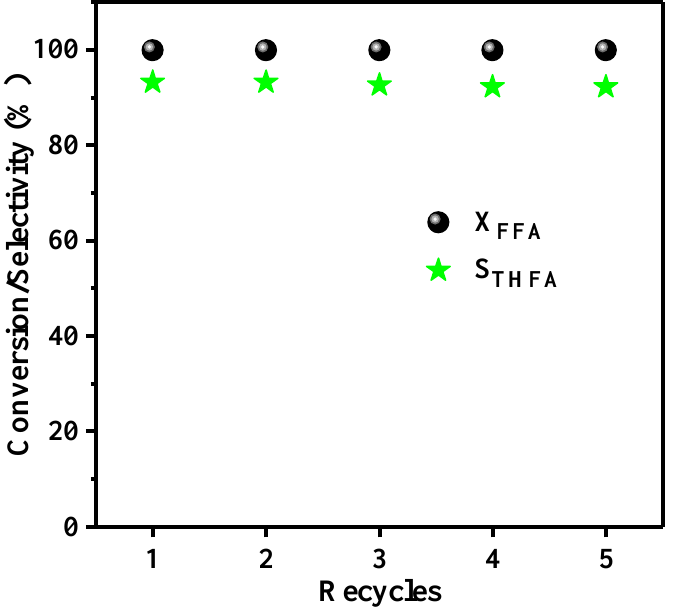
Figure 9. The catalyst reusability test in the hydrogenation of FFA. Reaction conditions: 0.030 g of 7.5Ni/m-TiO 2 , 1 mmol of furfural, 2 mL of H 2 O, 2 MPa of H 2 , 100 °C, and 4 h.